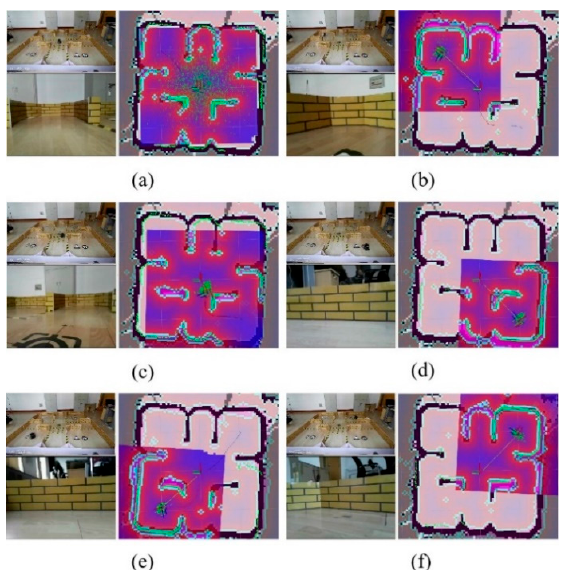
Figure 20. The sequence of snapshots for the execution of the task: “PutHandbookonBookshelf”. ( a ) The initial position of TurtleBot3; ( b ) The atomic action of MovetoHandbook. ( c ) The atomic action of MovetoLeo; ( d ) The arrival at the position of Leo; ( e ) The atomic action of BatteryCharge; ( f ) The action of MovetoBookshelf.